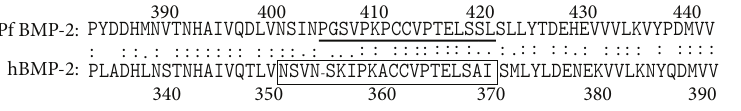
Figure 5: Pairwise sequence alignment of Pf BMP-2 and human BMP-2. The residue numbers indicate the positions of the amino acids in the BMP-2 precursor before processing. The closed box indicates the human BMP-2 functional domain (the knuckle epitope of human BMP-2). The bold underline indicates the synthetic polypeptides for examining the osteogenic activity of Pf BMP-2. : denotes identical residues in two BMP-2 orthologs; ∙ denotes a moderately conserved